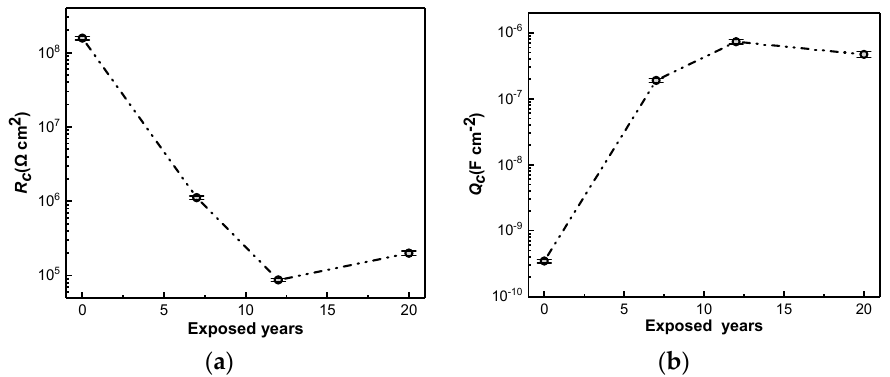
Figure 20. Variations in the ( a ) resistance R c and ( b ) capacitance Q c of the epoxy primer-coated specimens exposed for different numbers of years.